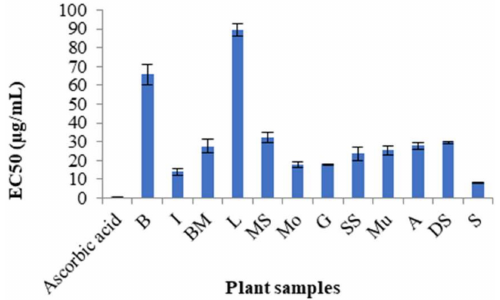
Figure 6. Antiradical scavenging activity of twelve plant samples of Matricaria chamomilla in the DPPH assay.